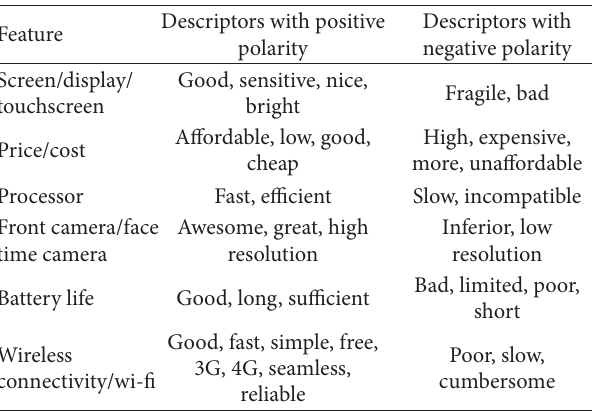
Table 1: Partial feature orientation table for